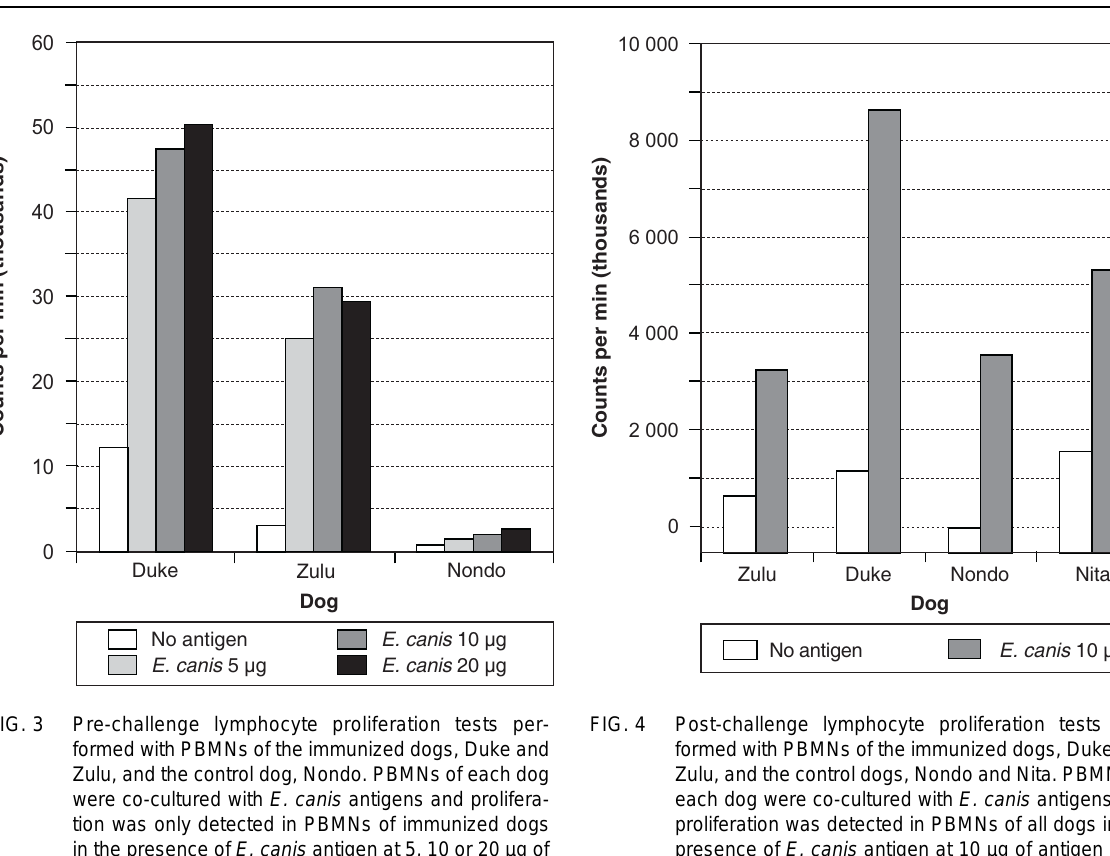
FIG. 3 Pre-challenge lymphocyte proliferation tests per- formed with PBMNs of the immunized dogs, Duke and Zulu, and the control dog, Nondo. PBMNs of each dog were co-cultured with E. canis antigens and prolifera- tion was only detected in PBMNs of immunized dogs in the presence of E. canis antigen at 5, 10 or 20 µg of